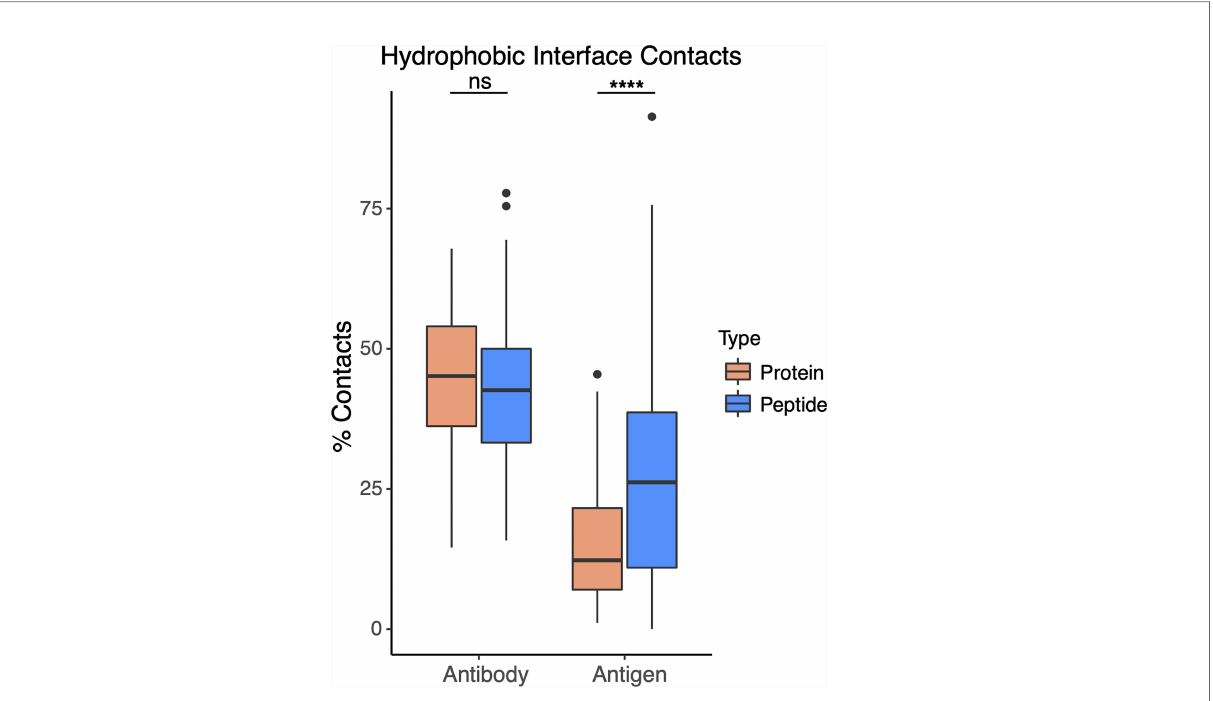
FIGURE 7 | Hydrophobic atom contacts in antibody-peptide and antibody-protein complexes. Percent of total atom contacts (< 4.5 Å distance to binding partner) for hydrophobic residue side chains were calculated separately for antibody and antigen in each antibody-protein (N=54) and antibody-peptide (N=188) interface. Statistical signi fi cance between sets of values were determined by Wilcoxon rank sum test (ns: p > 0.05; ****: p ≤